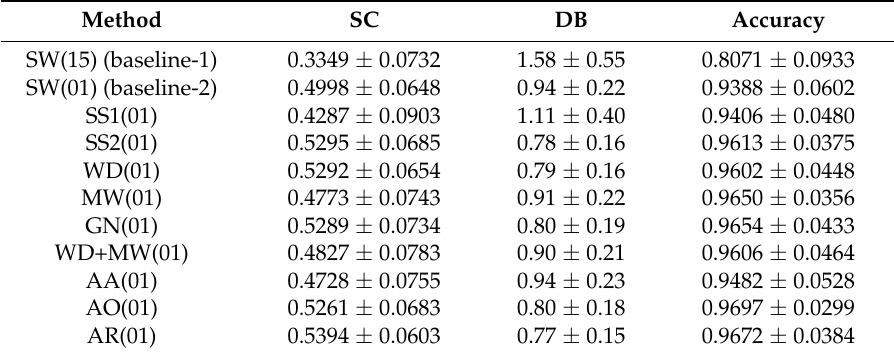
Table A9. Average and standard deviation across subjects of the cluster metrics Silhouette Coefficient (SC), Davies–Bouldin (DB) and classification accuracy (row of R = 15 in Table A7) for the putEMG